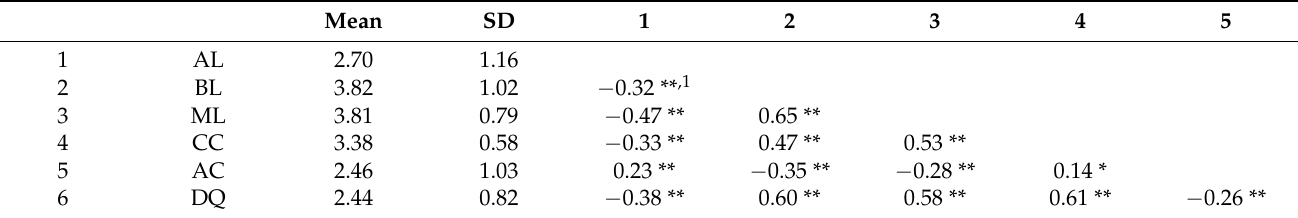
Table 2. Means, Standard Deviations, and Correlations of Study Variables (n =